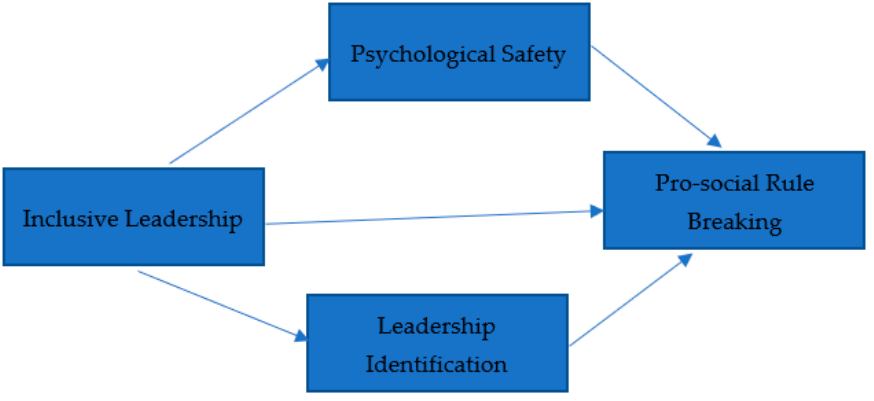
Figure 1. Conceptual Framework of the Present